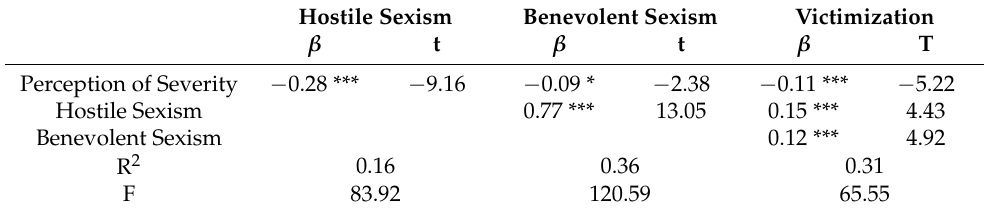
Table 4. Mediation model.